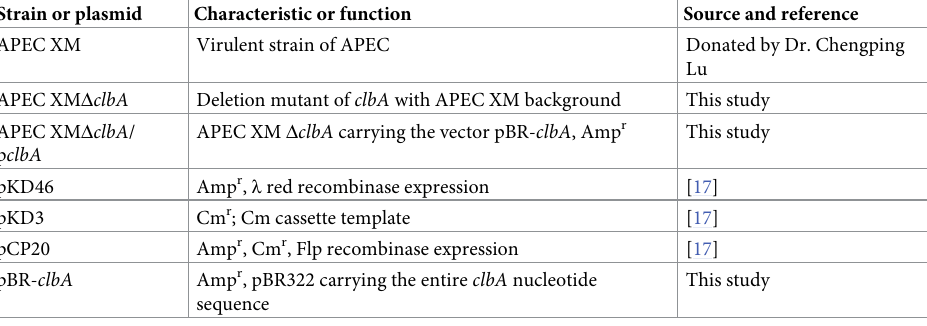
Table 1. Bacterial strains and plasmids used in this